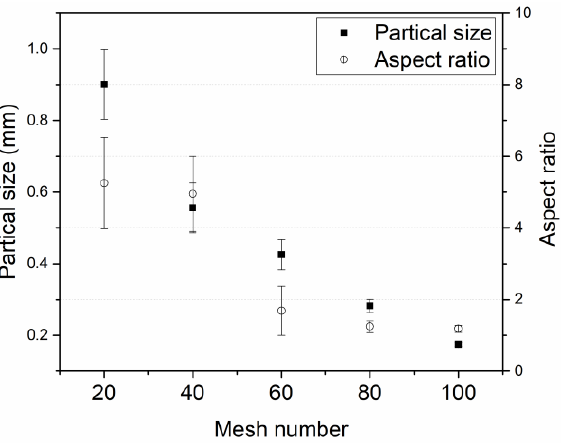
Figure 1. Particle size and aspect ratios of straw powder after screening with different mesh